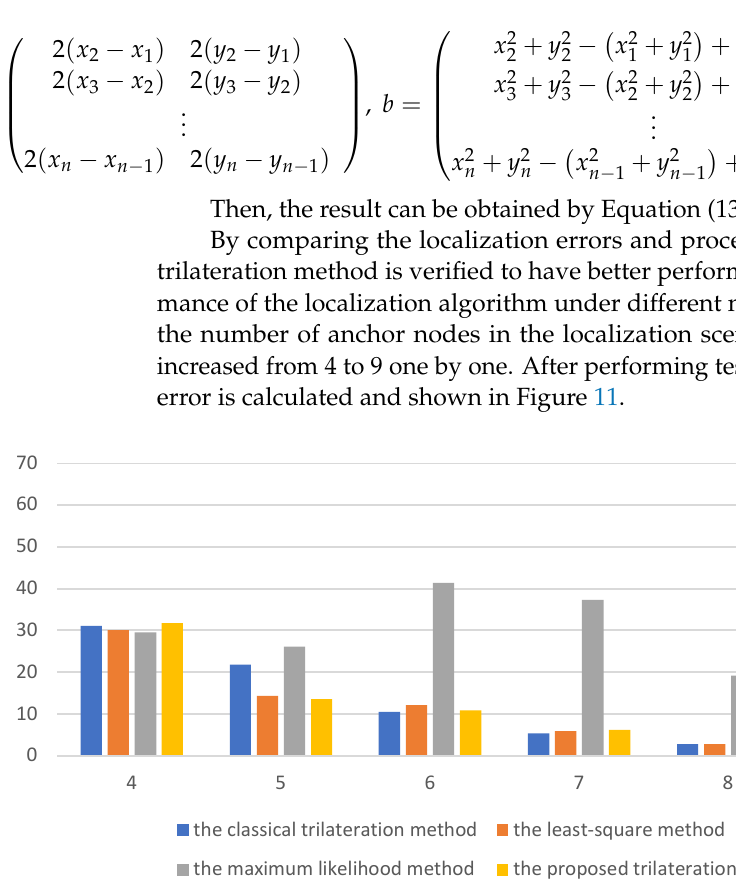
Figure 11. The localization error of different positioning methods.